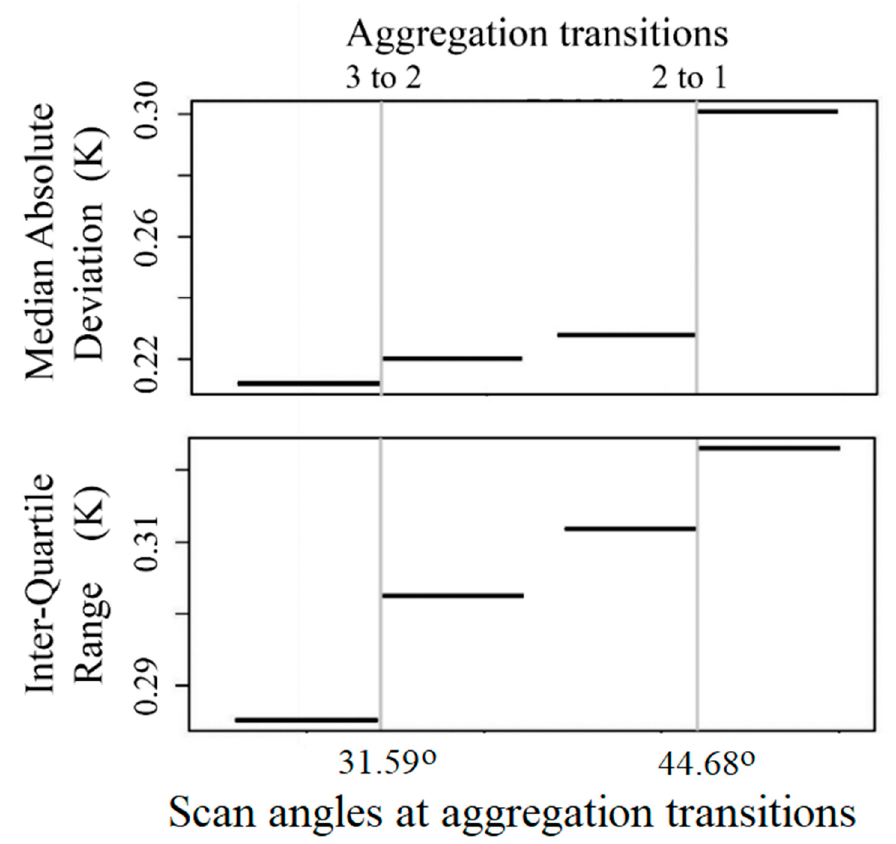
Figure 14. Influence of pixel aggregation on the Median Absolute Deviation ( top ) and the Inter-Quartile Range ( bottom ). The values are from comparisons between VIIRS SSTskin and the subsurface temperature measurements from drifters.